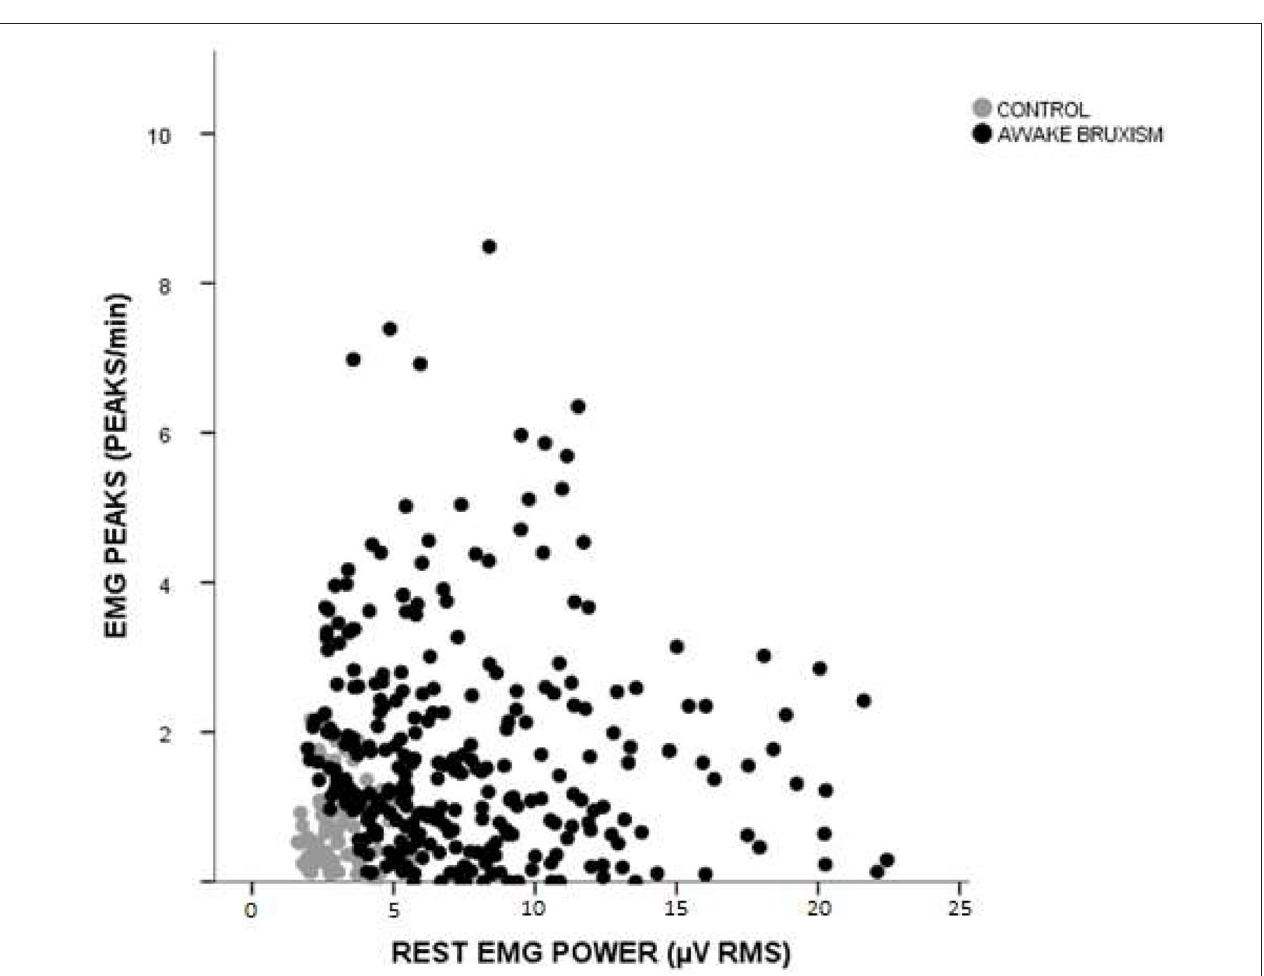
FIGURE 2 | Distribution of participants according to the number of phasic contractions and EMG power at rest. Gray circles: control group (individuals without awake bruxism; n = 77). Black circles: awake bruxism group ( n = 308). EMG, electromyography; RMS, Root mean square.